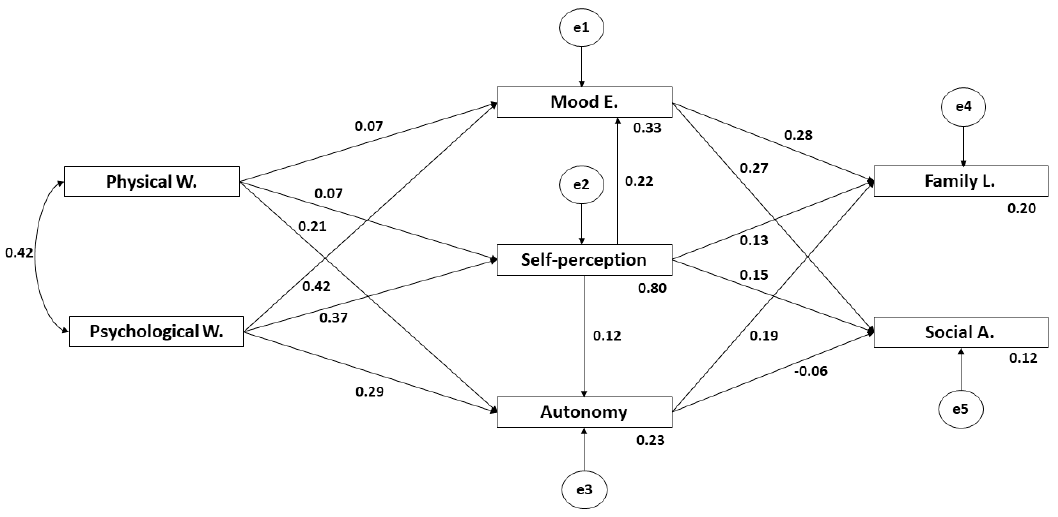
Figure 2. Structural equation model. Table 1. Structural